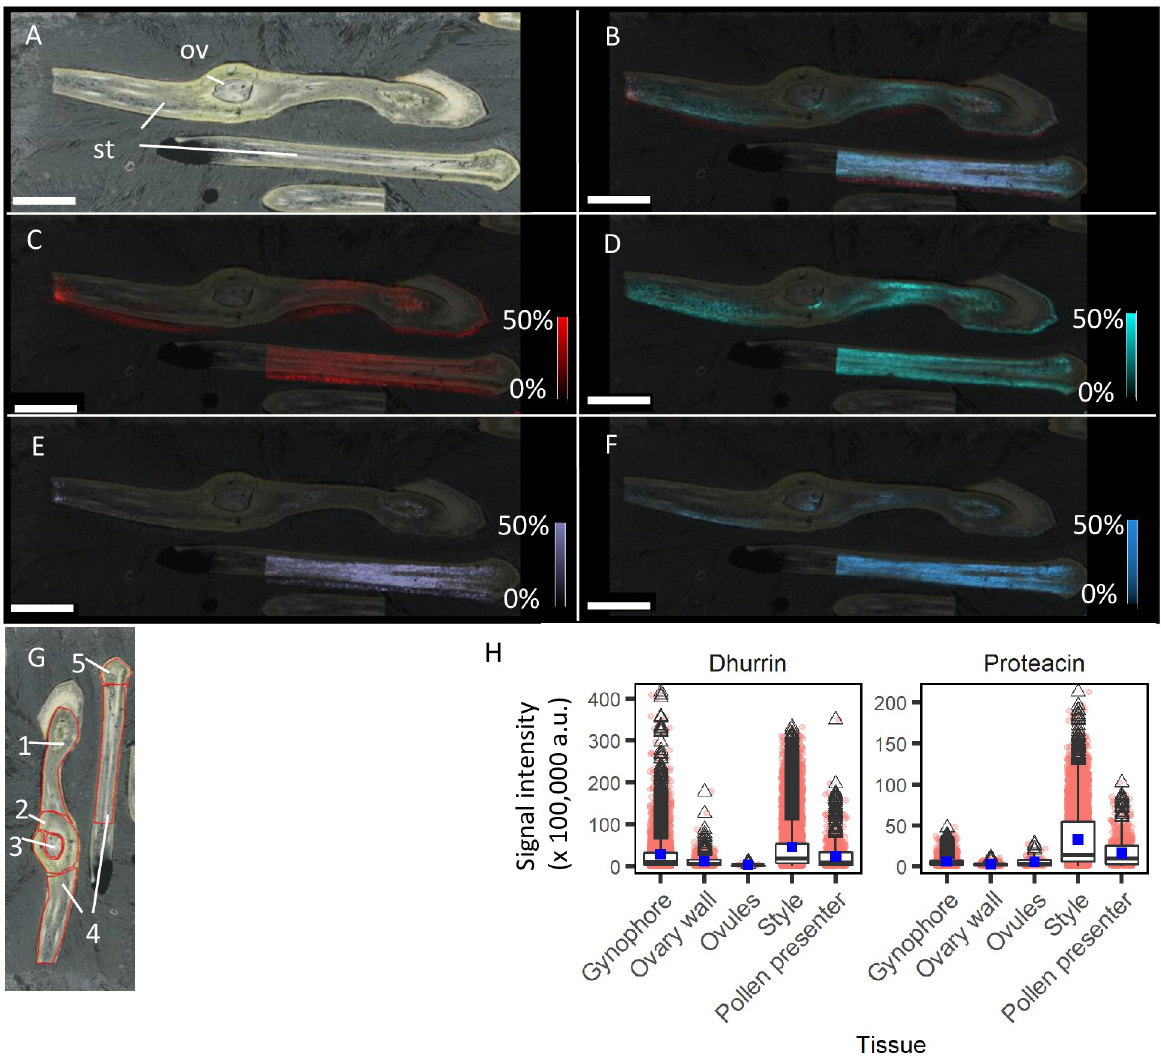
Fig 3. MALDI-MS images of a longitudinal section of a senescent floret of Grevillea robusta . (A) Optical image of section (35 μ m thick), where st is style, ov–ovules. (B) Merged positive ion MALDI-MS image showing dhurrin and proteacin, (C) dhurrin [M + Na] + ( m/z 334.0896, Δ m 0.3 mDa), (D) dhurrin [M + K] + ( m/z 350.0635, Δ m 0.6 mDa), (E) proteacin [M + Na] + ( m/z 496.1421, Δ m 0.8 mDa) and (F) proteacin [M + K] + ( m/z 512.1164, Δ m 0.2 mDa). All MALDI-MS images were obtained using 50 × 50 μ m array. White scale bars indicate 2 mm. Coloured intensity scales represents 0–50% TIC normalised signal intensity. (G) Regions of Interest (ROIs) selected for cyanogenic glycoside signal intensities comparison analysis–(1) gynophore, (2) ovary wall, (3) ovules, (4) style, (5) pollen presenter. (H) Signal intensities of dhurrin ([M + K] + ( m/z 350.0635), and [M + Na] + ( m/z 334.0896) combined), and proteacin ([M + K] + ( m/z 512.1164) and [M + Na] + ( m/z 496.1421) combined) for respective ROIs; the box plot represents the entire signal intensity delimited by the 25 th and 75 th percentiles, with error bars denoting the 10 th and 90 th percentiles. Values outside those ranges are represented by open triangles, the mean (dark blue square) and median (solid line). Pink dots represent signal intensity in individual pixel. Dhurrin to proteacin ratios in tissues are provided in S4